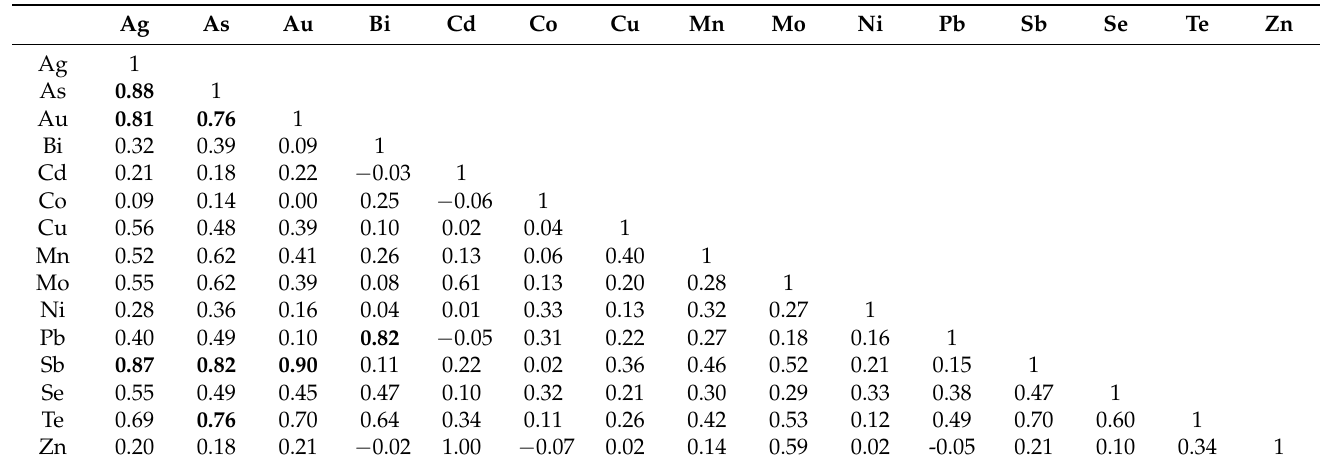
Table 2. Correlation matrix of trace elements in pyrite.